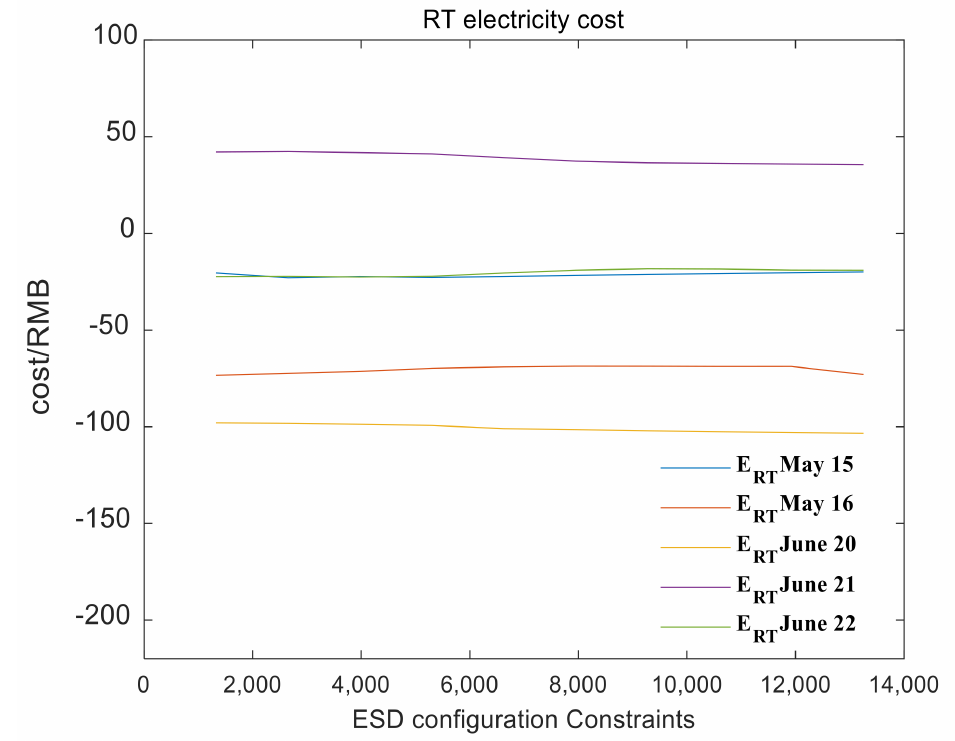
Figure 12. RT electricity cost optimization results.